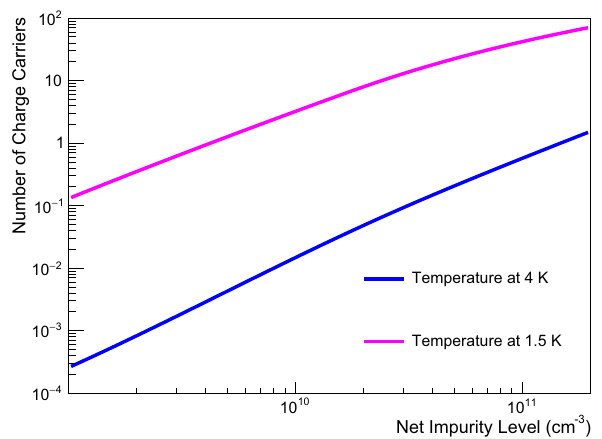
Fig. 10 Shown is the number of charge carriers created by the ioniza- tion or excitation of impurities as a function of impurity level in a given Ge detector. Two temperatures, 1.5 and 4 K, are